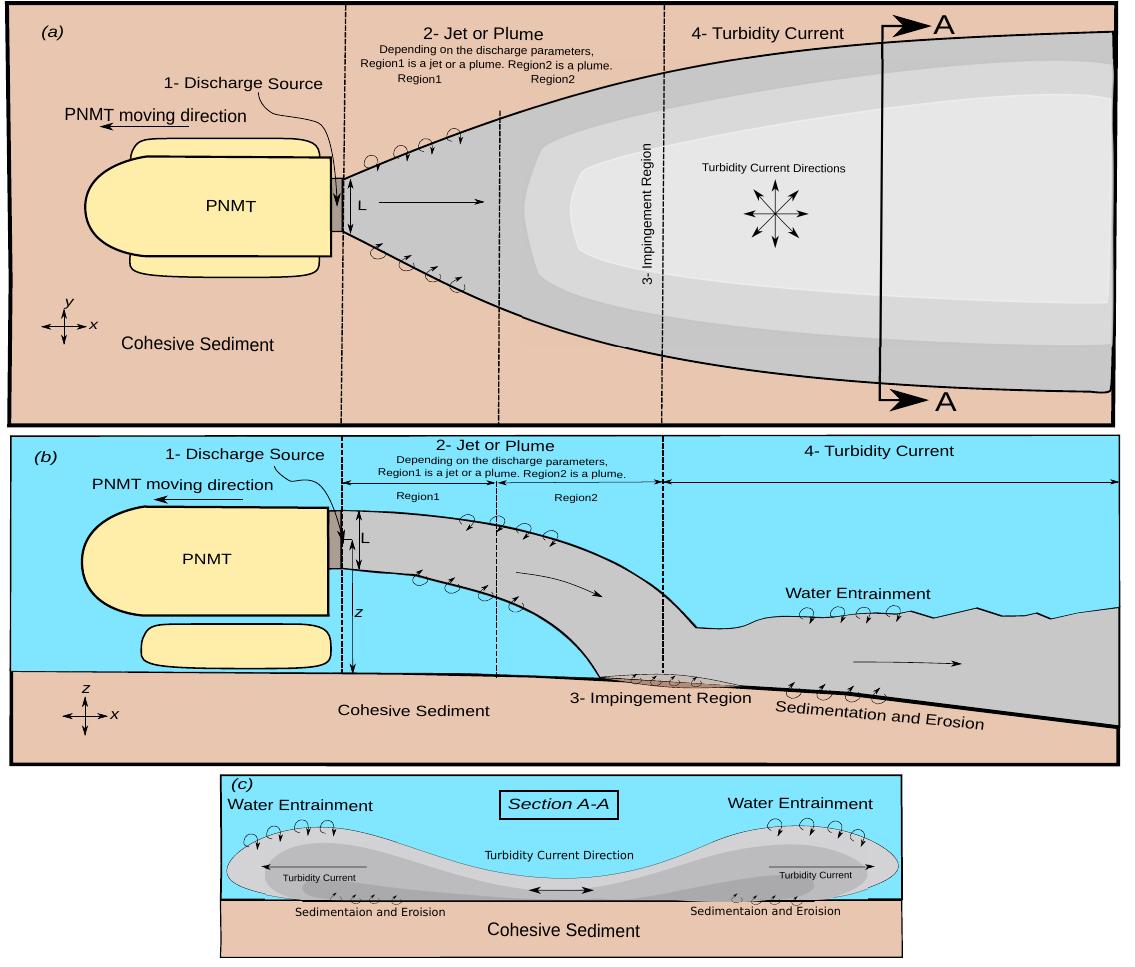
Figure 1. Conceptual sketch of the evolution of the sediment–water mixture discharged from a PNMT. ( a ) Top view of the discharge process from a PNMT; ( b ) right-side view of the discharge process from a PNMT [2]; ( c ) section A-A shows the direction of a turbidity